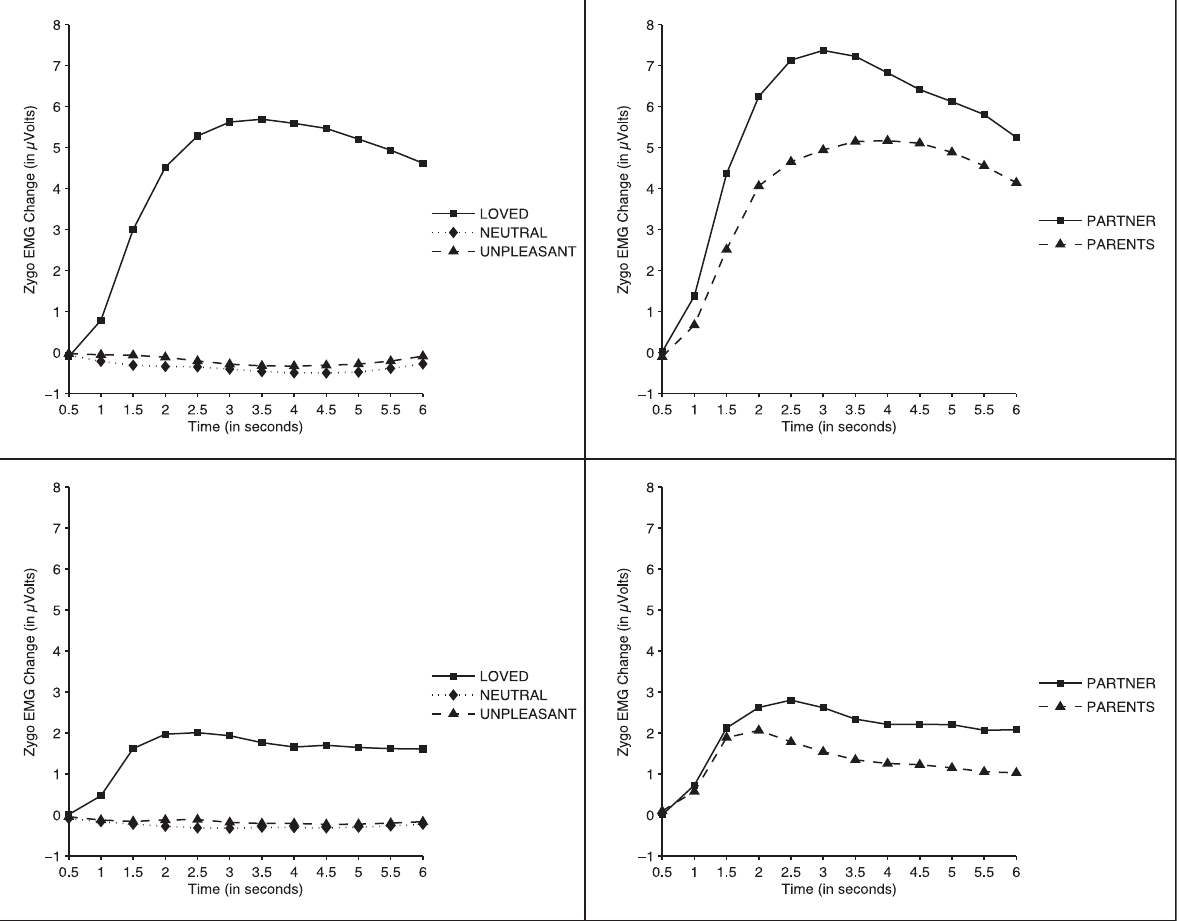
Figure 2. Zygomatic muscle response to the faces. Zygomatic muscle activity while participants viewed faces. Left: Loved vs. neutral vs. unpleasant faces (top: females; bottom: males). Right: Romantic partner (boyfriend/girlfriend) vs. same-sex parent (father/mother) faces (top: females; bottom: males).